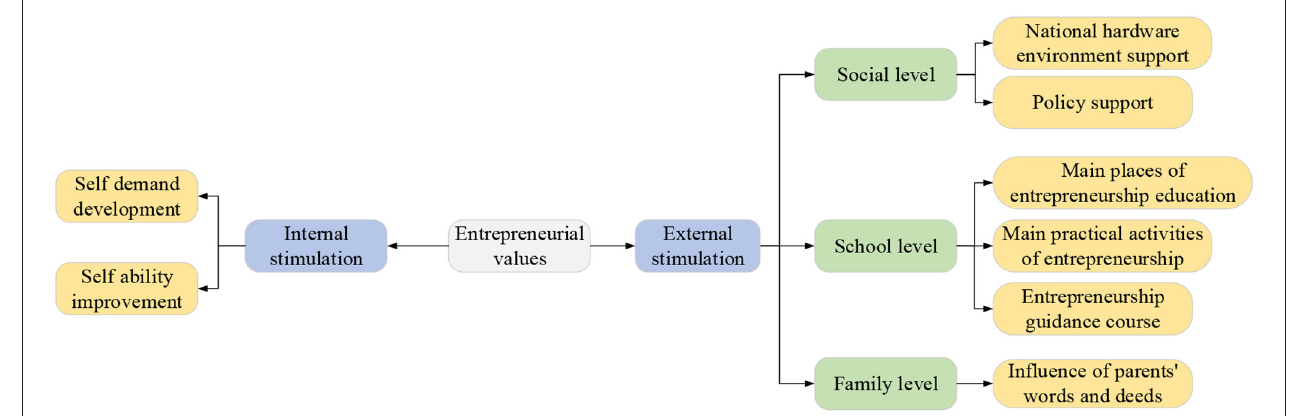
FIGURE 2 | Analysis of the formation characteristics of contemporary college students’ entrepreneurial